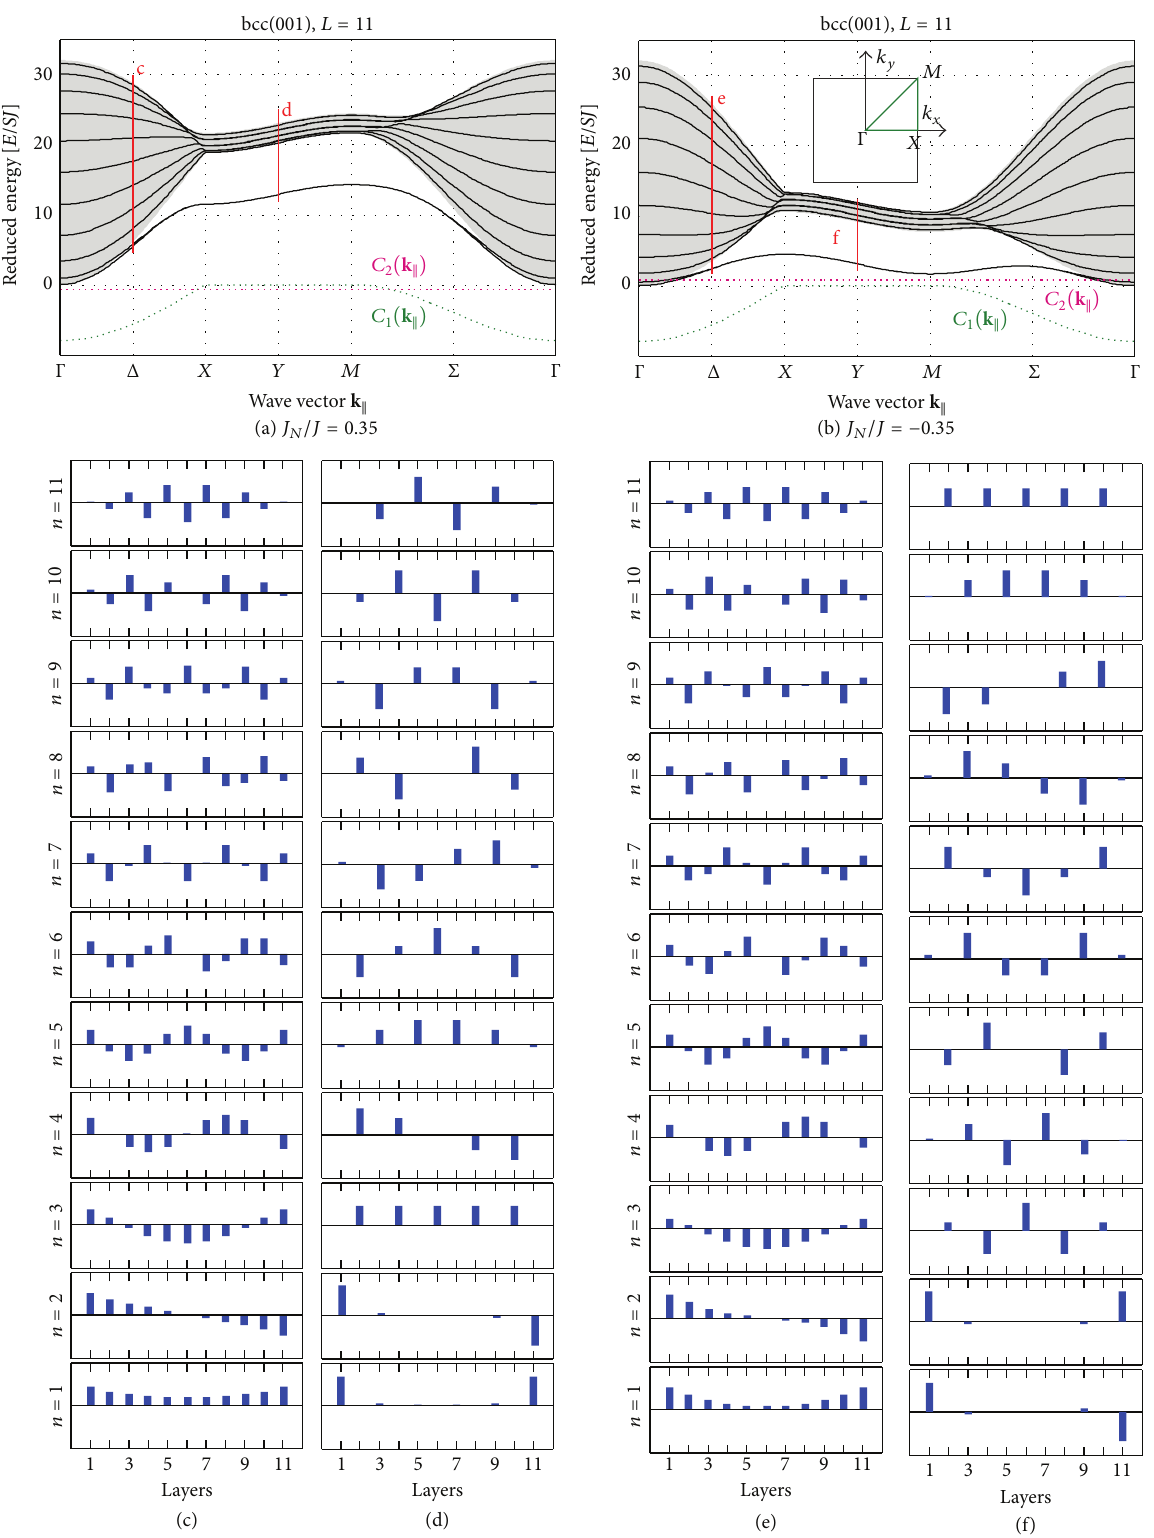
Figure 8: ((a), (b)) Spin-wave spectra of an 11-layer thick bcc(001) thin film with NNN exchange interactions (a) ferromagnetic and (b) antiferromagnetic. Solid lines represent the energy of individual modes; the shaded area is the bulk band for in-plane spin waves. Each spectrum is plotted along the high-symmetry path shown in (b), inset, and accompanied with the evolution of the off-diagonal Hamiltonian matrix elements 𝐶 1 and 𝐶 2 shown as a green and purple dotted line, respectively. ((c)–(f)) Mode profiles corresponding to points in the SBZ marked with red lines in ((a),